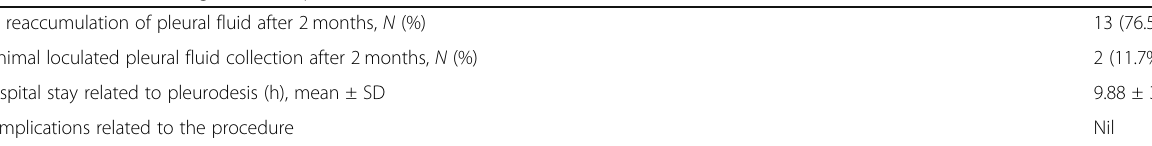
Table 3 Outcome of single session pleurodesis No reaccumulation of pleural fluid after 2 months, N (%) Minimal loculated pleural fluid collection after 2 months, N